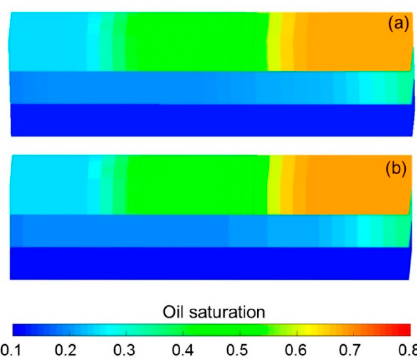
Figure 11. Comparison of 3D oil saturation distributions after cumulative injection volume of 1.67 PV obtained with ( a ) ECLIPSE V2013.1 software and ( b ) designed simulator in running the case without polymer degradation.